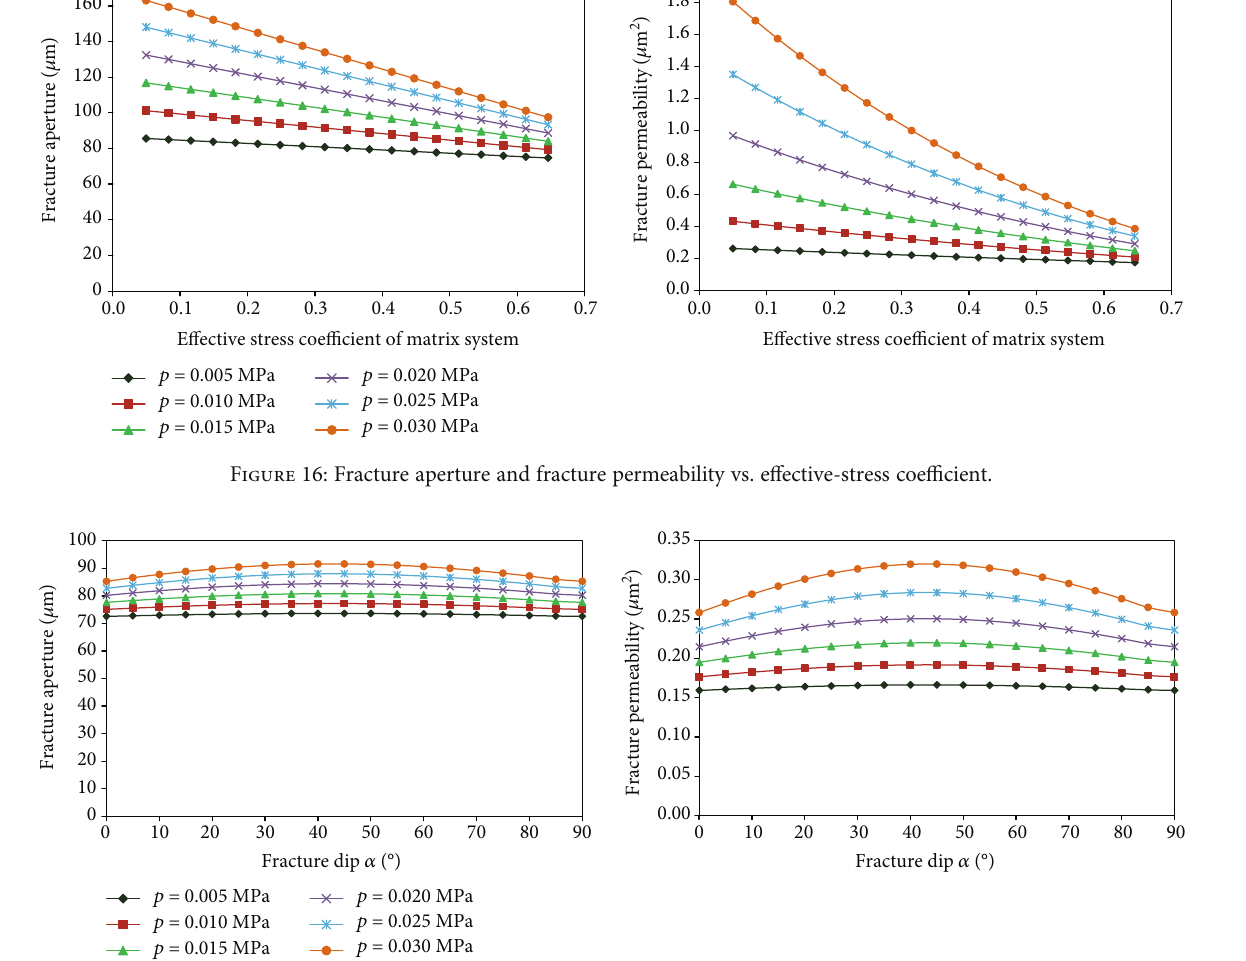
Figure 17: Fracture aperture and fracture permeability with fracture direction.